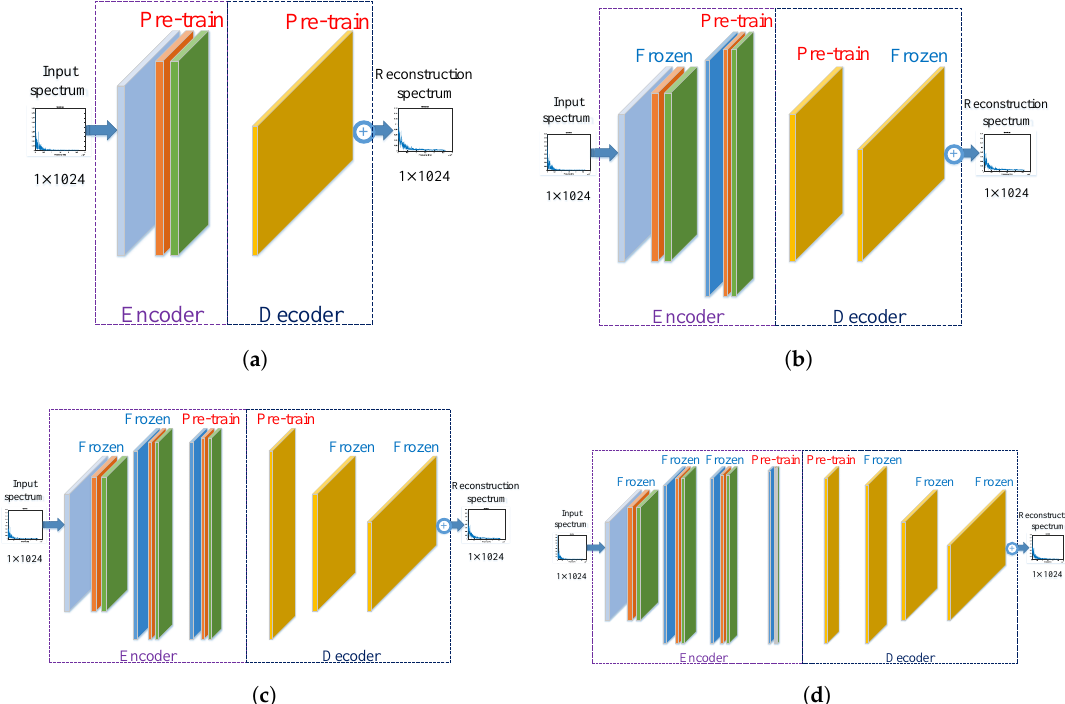
Figure 4. The procedure of layer-wise pre-training. ( a ) Pre-train layer1. ( b ) Pre-train layer 2. ( c ) Pre-train layer 3. ( d ) Pre-train layer